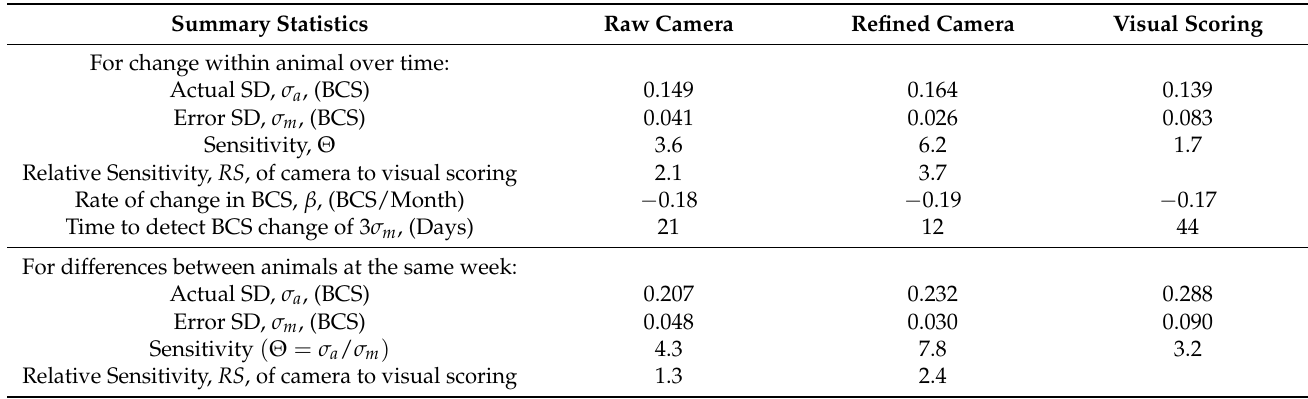
Table 2. Estimates of summary statistics for comparison of raw camera, refined camera, and visual body condition score (BCS) measurement methods. Each statistic relates to the response and/or precision of a cow by week mean. Under both camera methods each mean was an average of approximately 14 camera measurements, and under the visual scoring method, each mean was an average of 3 independent